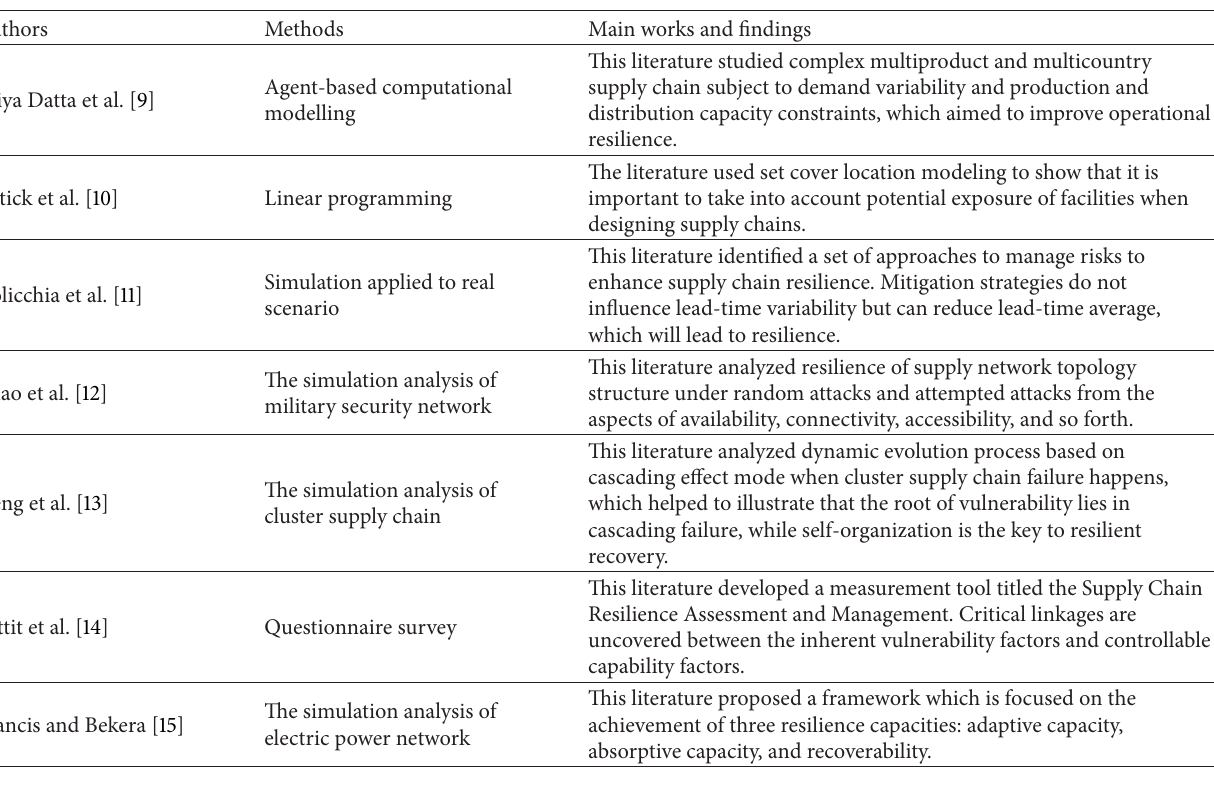
Table 2: Quantitative studies on supply chain resilience.